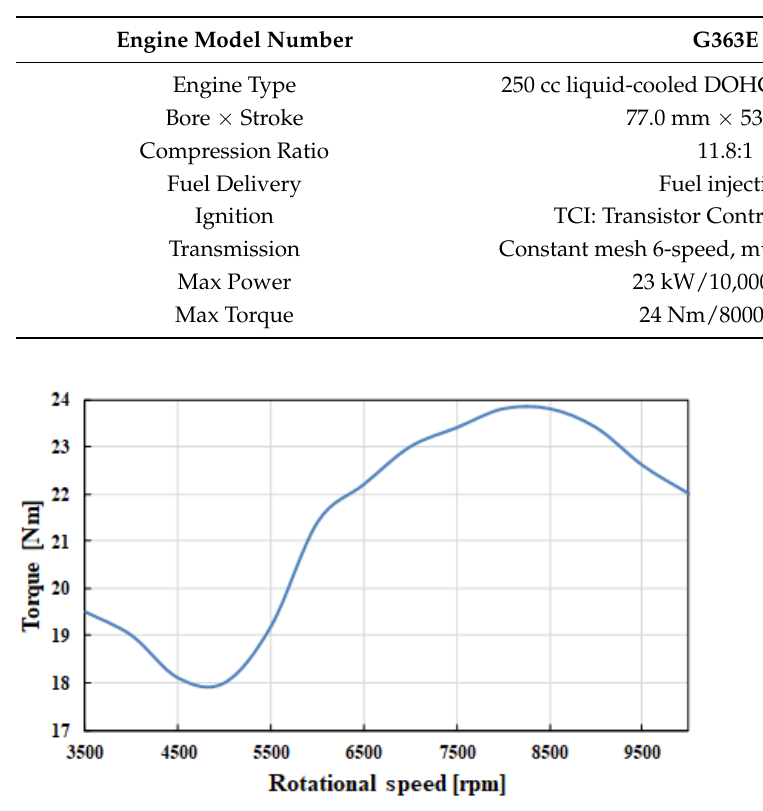
Figure 6. Relationship between ICE rotational speed and torque. The electric motor in the hybrid system is specified to have a maximum output of less than 30 kW and uses an air-cooled Motenergy ME0913 brushless motor, as shown in Figure 7. Table 2 lists the specifications of the electric motor, and Figure 8 shows the relationship between the rotational speed and